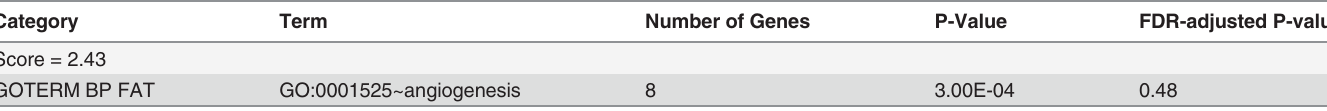
Table 6. Enriched (enrichment score > 2.0) clusters of Gene Ontology (GO) biological process (BP), molecular function (MF) Functional Annotation Tool (FAT) categories, and KEGG pathways among the genes under- or over-expressed in the active myostatin-reduced vs inactive myostatin-reduced contrast and not differentially expressed in all other